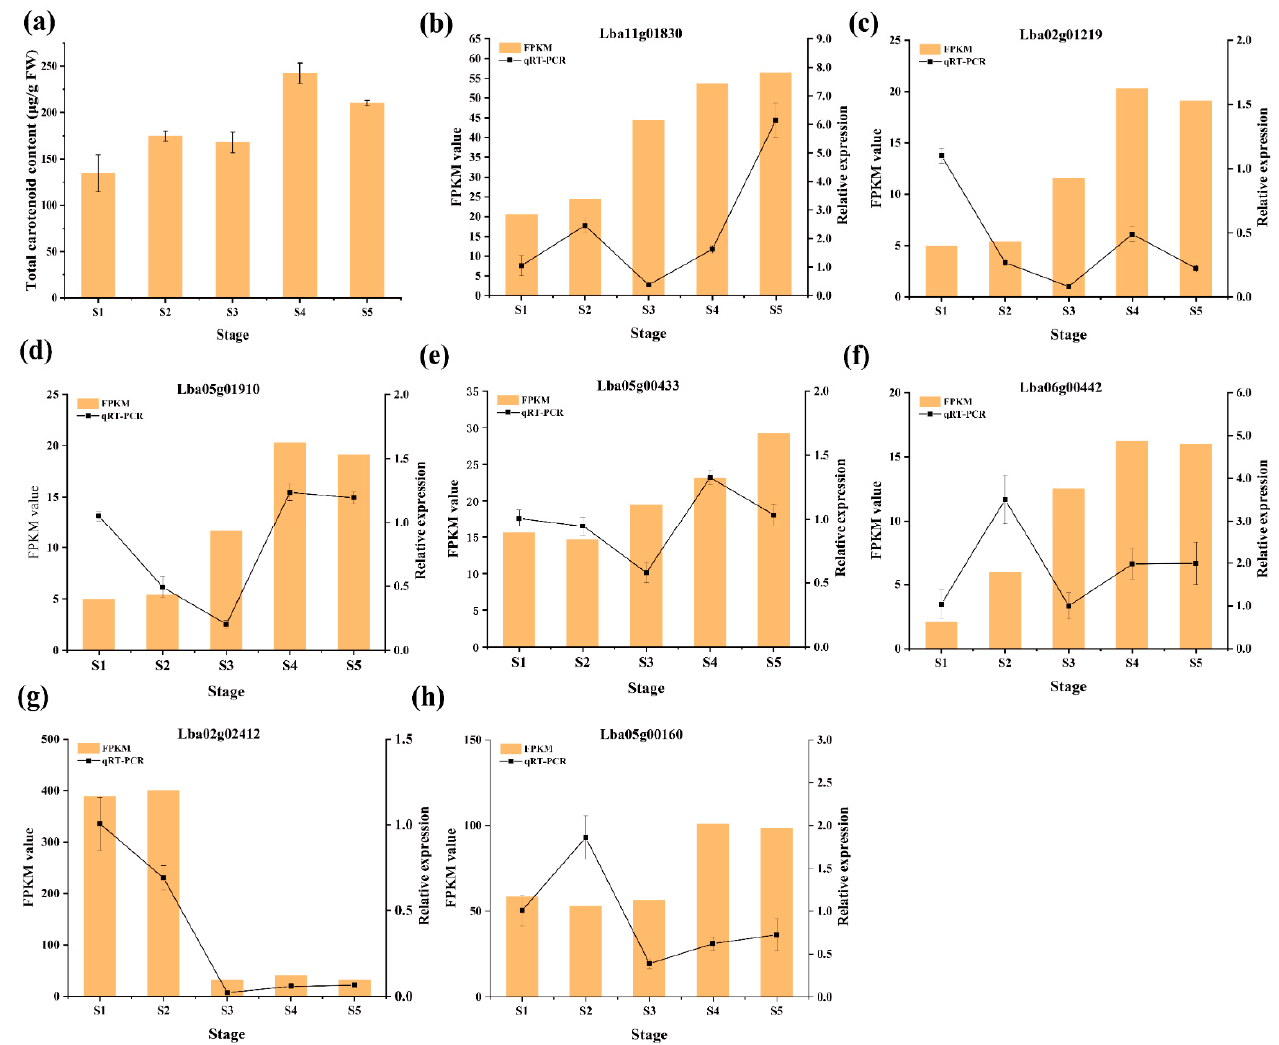
Figure 9. The relative expression levels of seven LbaR2R3-MYB genes at different stages. The x -axis indicates the five distinct periods. The y-axis indicates the relative expression and FPKM value. Data are presented as mean ± SDs ( n = 3 ). ( a ) Carotenoid contents; ( b ) Lba11g01830 ; ( c ) Lba02g01219 ; ( d ) Lba05g01910 ; ( e ) Lba05g00433 ; ( f ) Lba06g00442 ; ( g ) Lba02g02412 ; ( h ) Lba05g00160